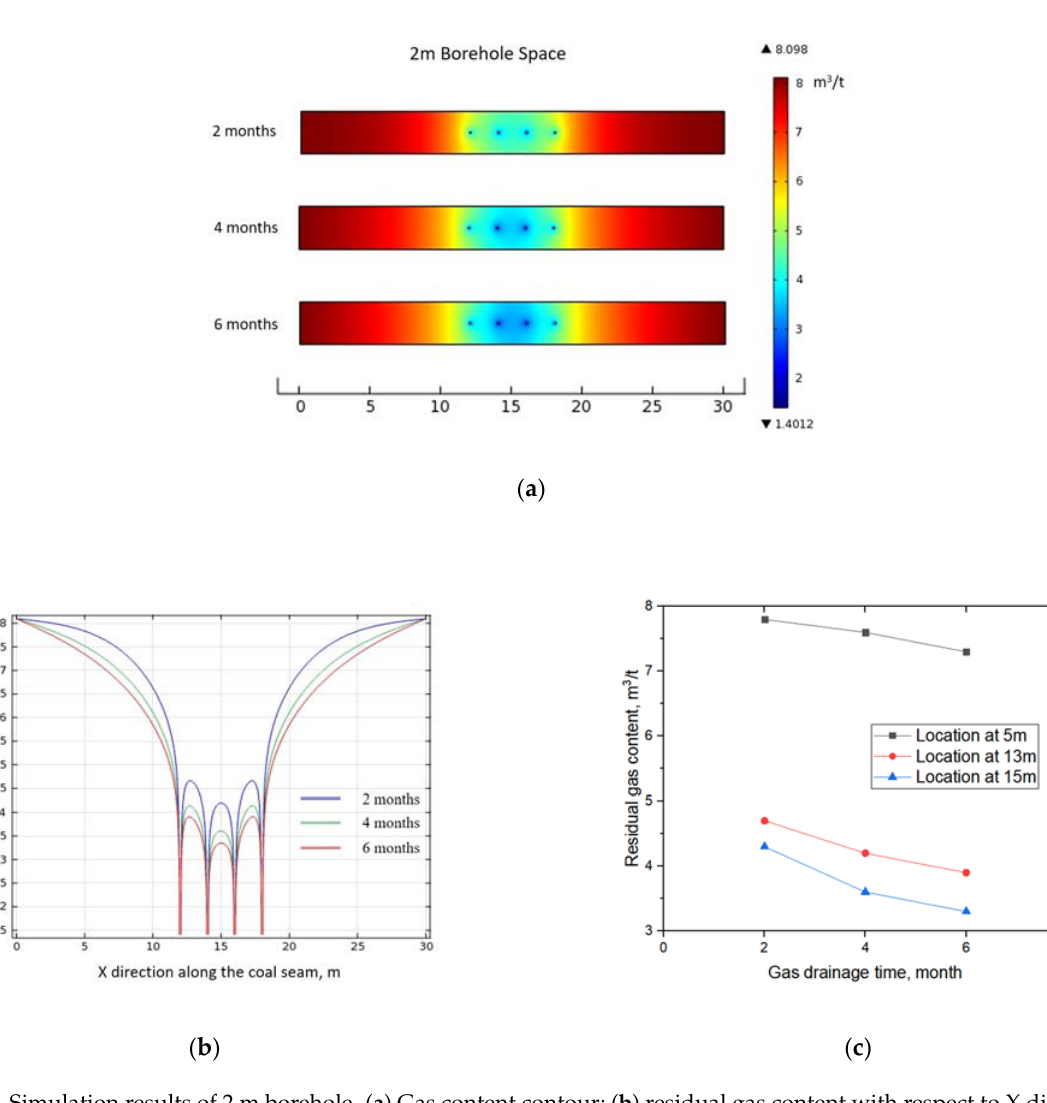
Figure 7. Simulation results of 2 m borehole. ( a ) Gas content contour; ( b ) residual gas content with respect to X direction along the coal seam; ( c ) gas content at three points with respect to gas drainage time.